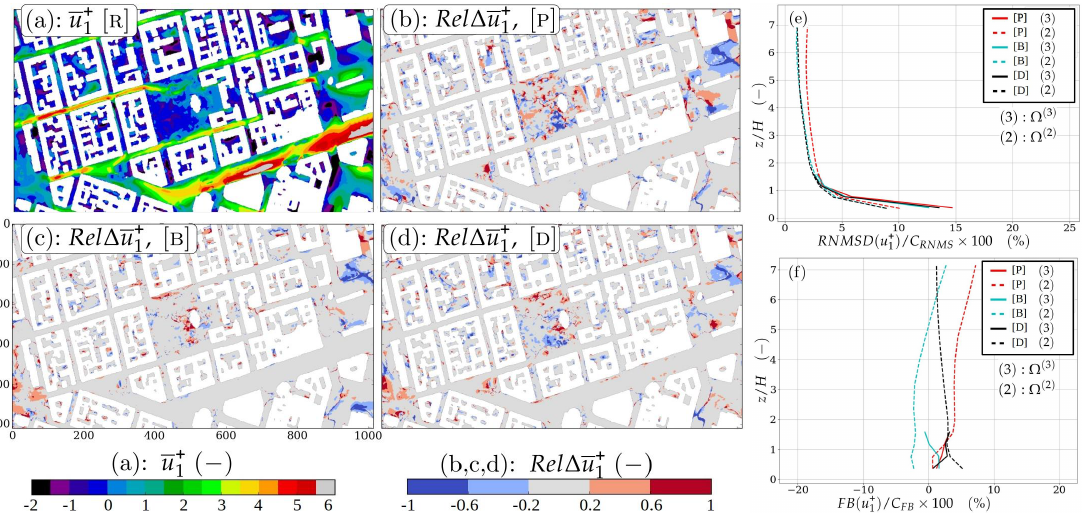
Figure 7. ( a ) Horizontal distribution of u + at z / H = 0.35. ( b – d ) Relative difference distributions 1 between cases [P] , [B] , and [D] . ( e ) Vertical variation of root-normalized-mean-square difference ) and ( f ) fractional bias FB ( u + ) evaluated over 12 horizontal planes across Ω ( 2 ) for heights RNMSD ( u + 1 1 0.35 < z / H < 7.2 and over 4 planes across Ω ( 3 ) for heights 0.35 < z / H < 1.6. Recommended criteria suggested by Chang and Hanna [69] are RNMSD < C RNMS (= 1.22 ) and | FB | ≤ C FB (= 0.3 ) , whereas zero is the ideal value for